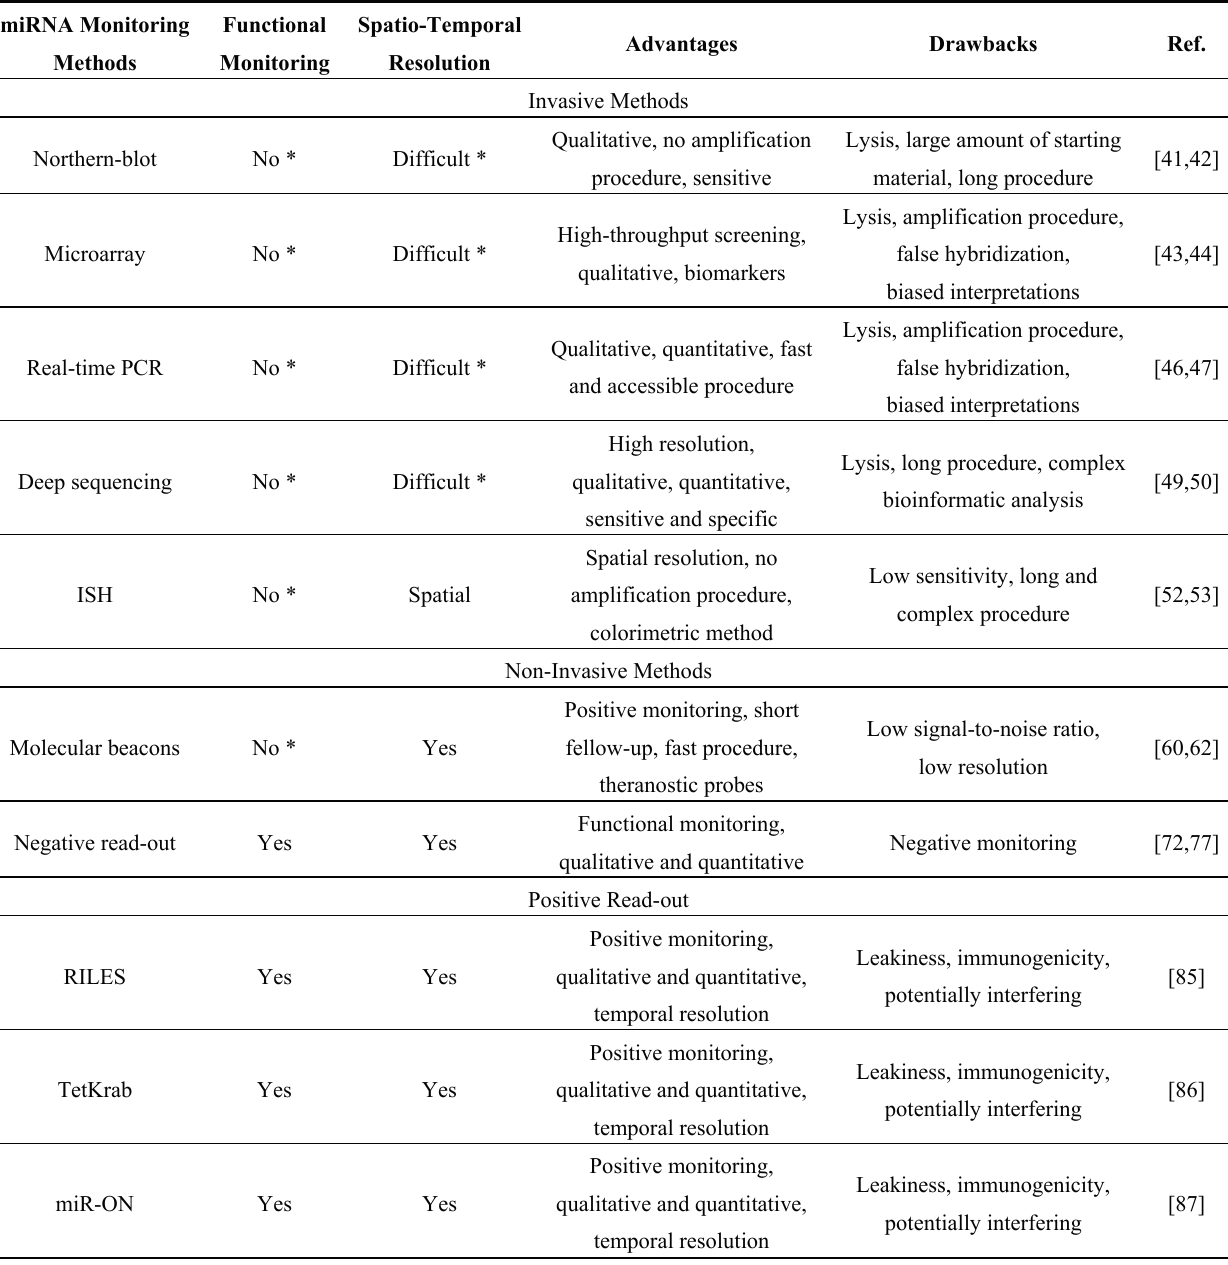
Table 1. Overview of the advantages and drawbacks of the current methods used